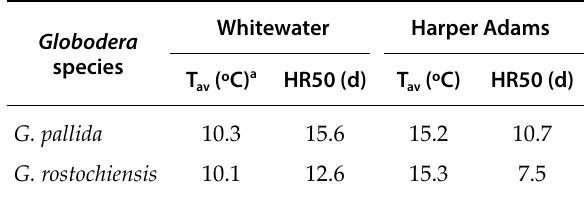
Table 2. Predicted number of days for 50% of the hatching of Globodera spp. to occur (HR50), at Whitewater, Scotland and Harper Adams, England, using soil temperature data collected at 20 cm depth in potato